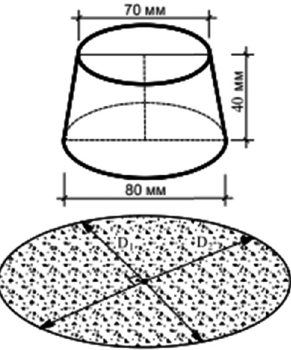
Figure 2: Truncated minicone for determining the fl ow of a fi ne - grained